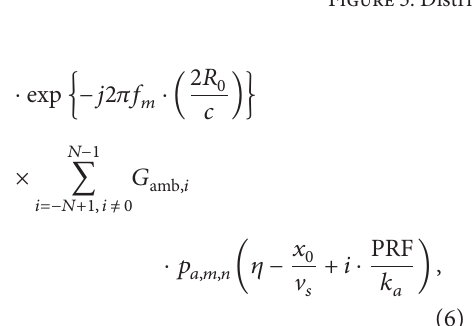
Figure 5: Distribution of the